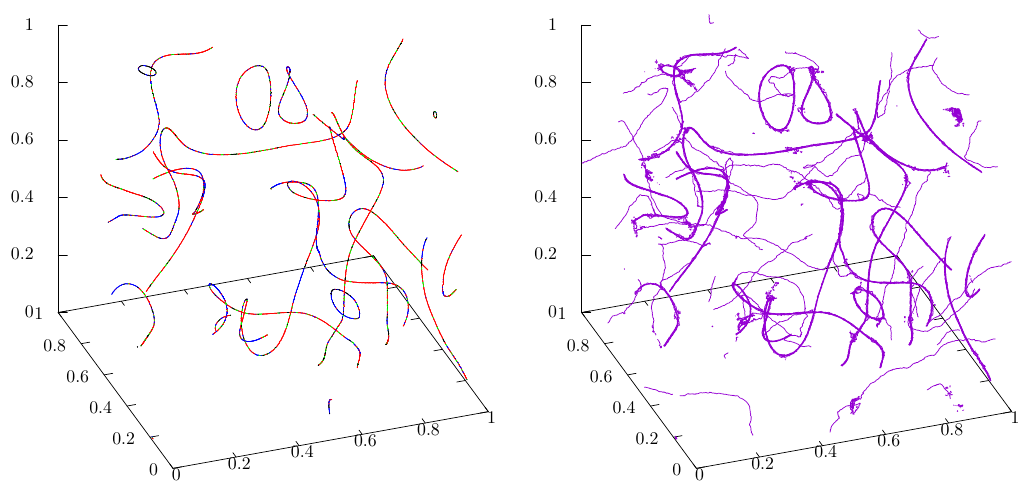
Figure 9 . Fraction of strings with various n 2 for ( q 1 ; q 2 ; (cid:17) 2 =(cid:17) 1 ) = (1 ; 4; 0 : 25) ( left). String core of the (cid:30) 2 -string (right). The segments of the (cid:30) 1 -strings are colored in red for ( n 1 ; n 2 ) = (1 ; 4) , in blue for ( n 1 ; n 2 ) = (1 ; 3) , and in green for ( n 1 ; n 2 ) = (1 ; 5) .